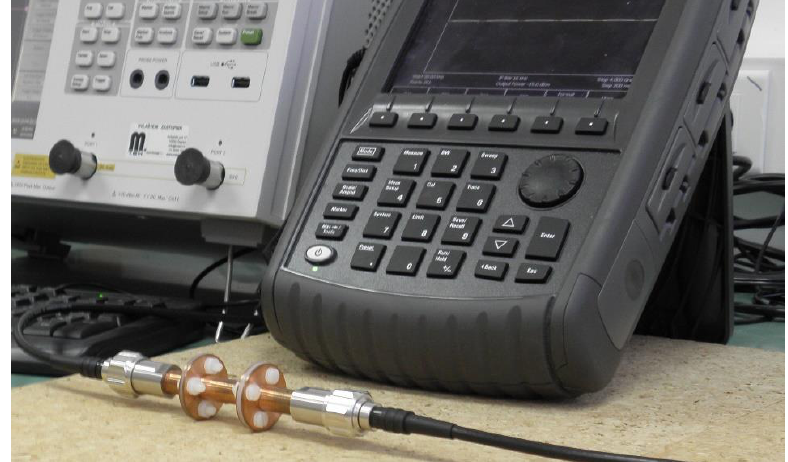
Figure 15. Measurement setup for characterization of adiabatic line-scattering parameters .